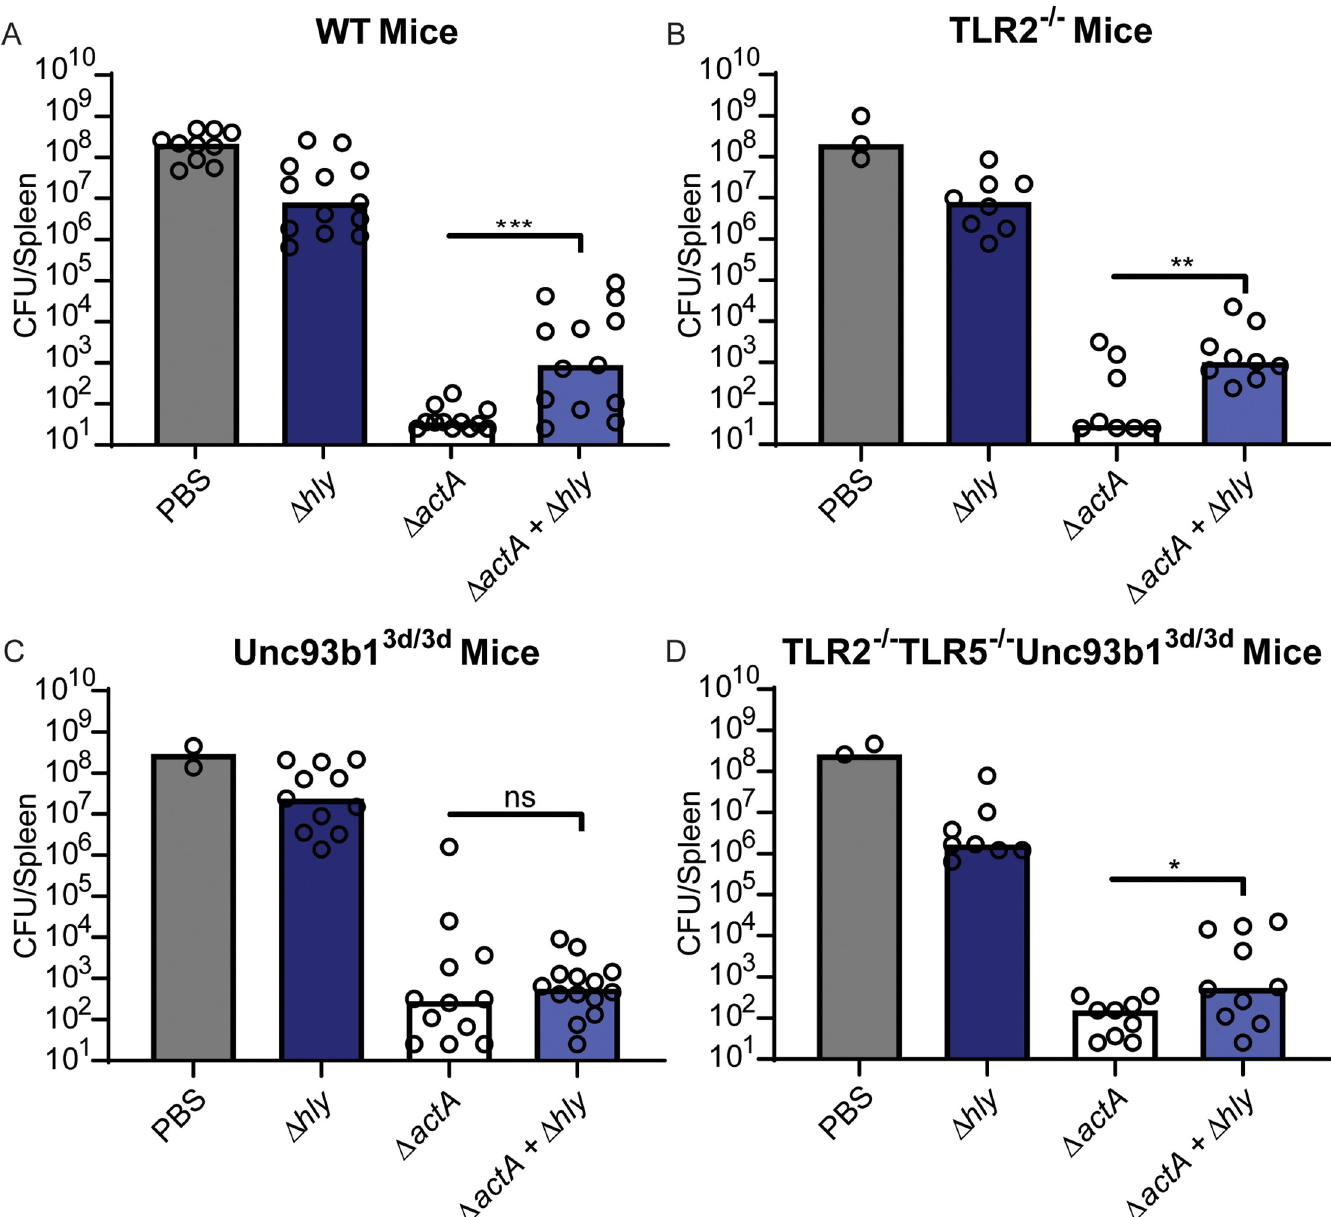
Fig 5. Immune suppression is primarily mediated by endosomal TLR signaling. Mice were infected with 10 8 CFU of Δ hly background strains or 10 5 CFU of Δ actA . WT C57BL/6J mice (A), TLR2 -/- (B), Unc93b1 3d/3d (C), and TLR2 -/- TLR5 -/- Unc93b1 3d/3d (D) were infected. Eight weeks post-vaccination, mice were challenged with 5x10 5 WT L . monocytogenes . CFU from the spleen were enumerated three days post-challenge. Data are pooled from two to four independent experiments. Bar represents the median. Data analyzed using an unpaired t test.